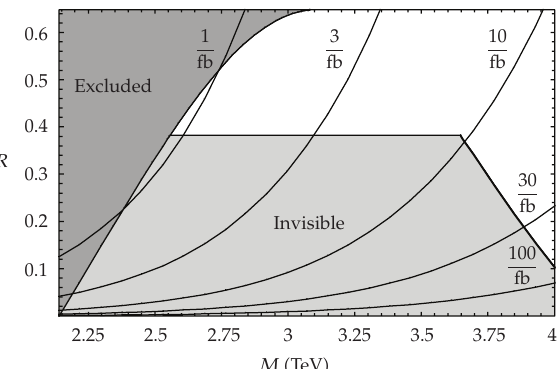
(cid:17) S < 3 × 10 − 3 . The